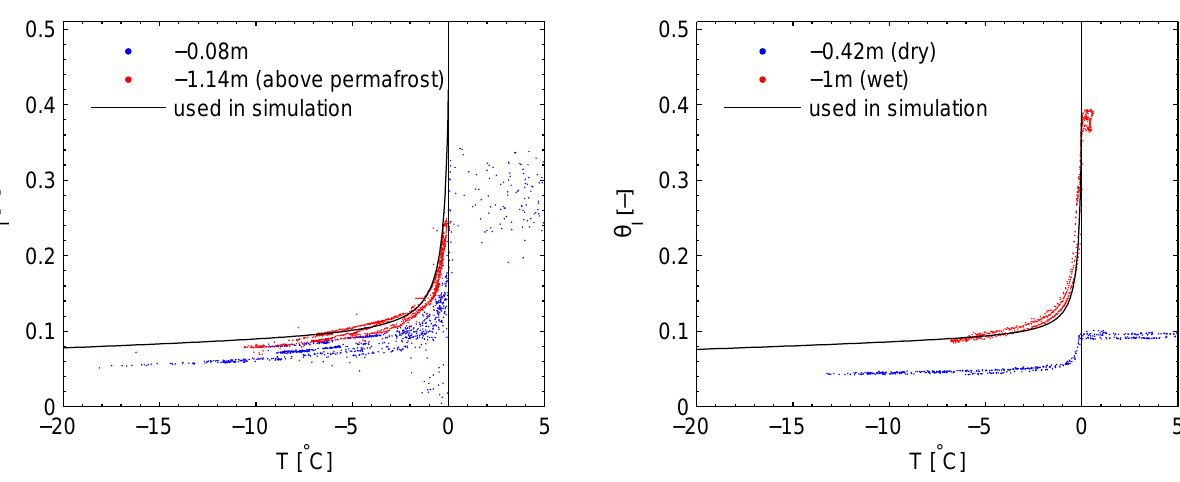
Fig. 4. Measured soil freezing characteristics and manually adapted fits for θ w = φ . Left: Bayelva, right: Tianshuihai. in the different layers three different heat conductivities K h soil and manual optimization of all other parameters. The